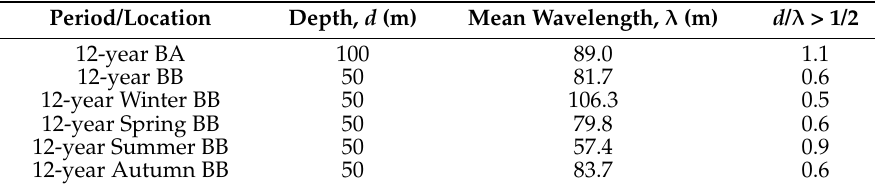
Table 4. Summary of deep water waves condition at BA and